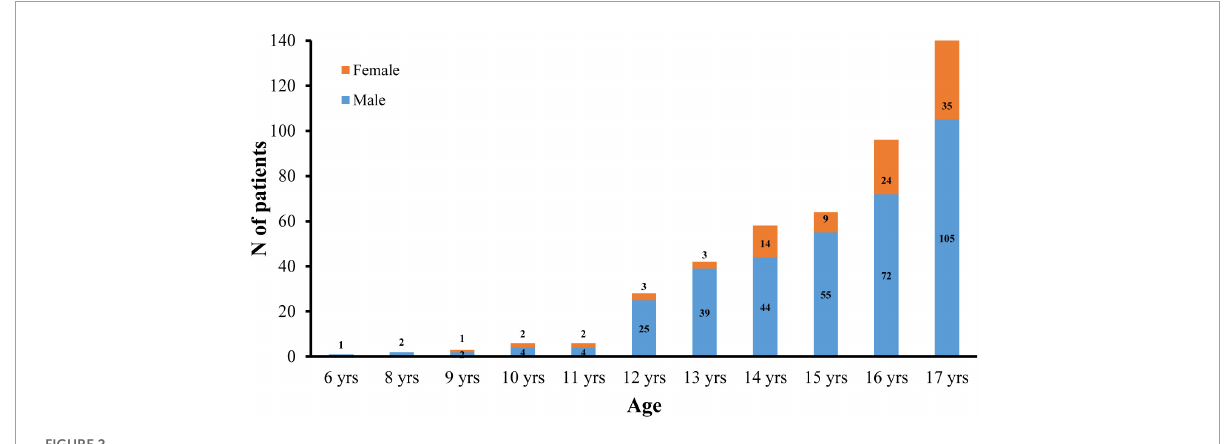
FIGURE2 Gender distribution of pediatric KC patients in different age groups.